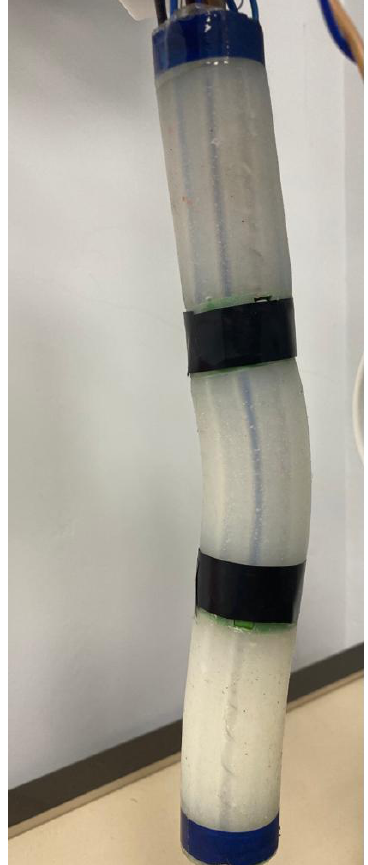
Figure 26. Ruan, a soft robot.